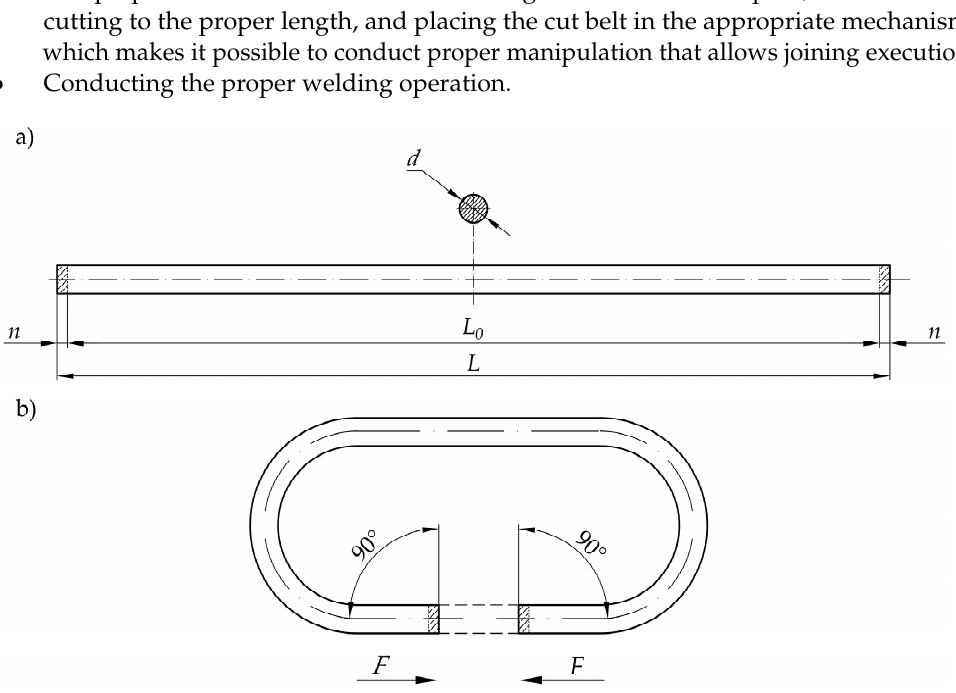
Figure 1. Preparation of the belt before the hot plate welding operation: ( a ) cutting to the proper length and ( b ) manipulation of the ends of the belt to obtain their proper orientation.